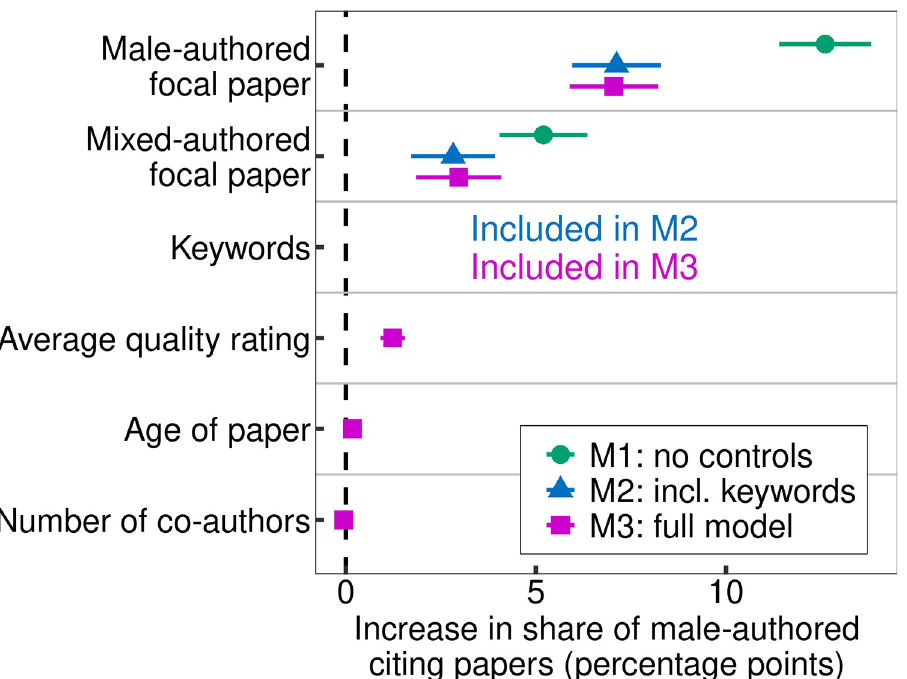
Fig 2. Marginal effects (with 95% confidence intervals) of three regression models on the level of focal papers. For each model, the dependent variable is the share of male-authored papers among the citing papers. In addition to the gender of the focal papers’ authors, we successively included as possible structural factors the focal papers’ keywords for research topics (in the form of binary variables to control for all 334 keywords in the Faculty Opinions database), the quality rating (average quality rating in case of quality ratings by multiple experts for one paper), the age of the papers (publication year), and the number of authors. All models are based on 38,439 observations (focal papers). For more information and detailed analyses, see S1.3 in S1